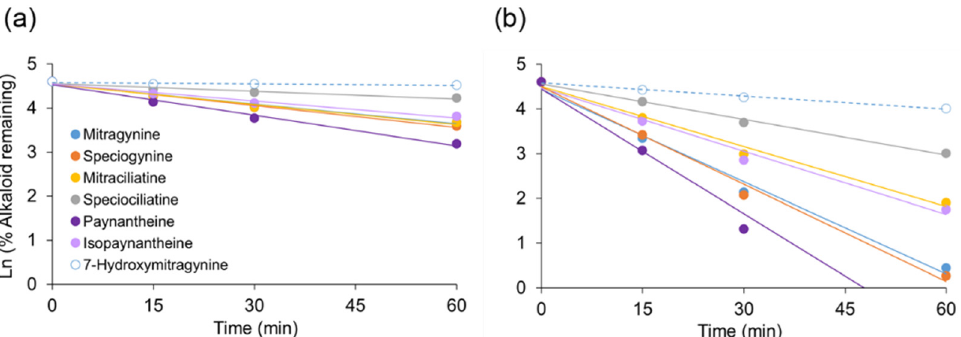
Figure 6. NADPH-dependent depletion of each kratom alkaloid (1 µM) incubated with human ( a ) intestinal and ( b ) liver microsomes (0.5 mg/mL) at 37 °C. Symbols denote means of triplicate incubations, which varied less than 15%. Error bars are not shown for visualization purposes. Lines denote linear regression (R 2 > 0.9) of the data, and negative slopes indicate in vitro rate of elimination (k e ). The 60 min timepoint for paynantheine in ( b ) is not shown to allow direct comparison between ( a , b ) using a common scale. The k e was estimated using all data points.